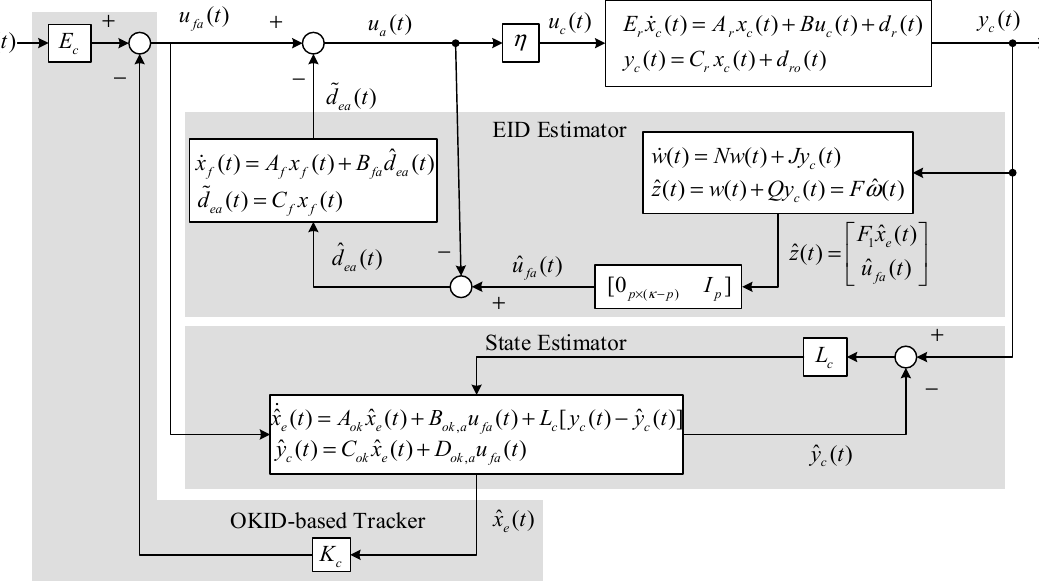
Figure 1. An observer–Kalman-filter (OKID)-based linear quadratic analog tracker (LQAT) with a functional observer for non-square singular systems. EID, equivalent input disturbance.